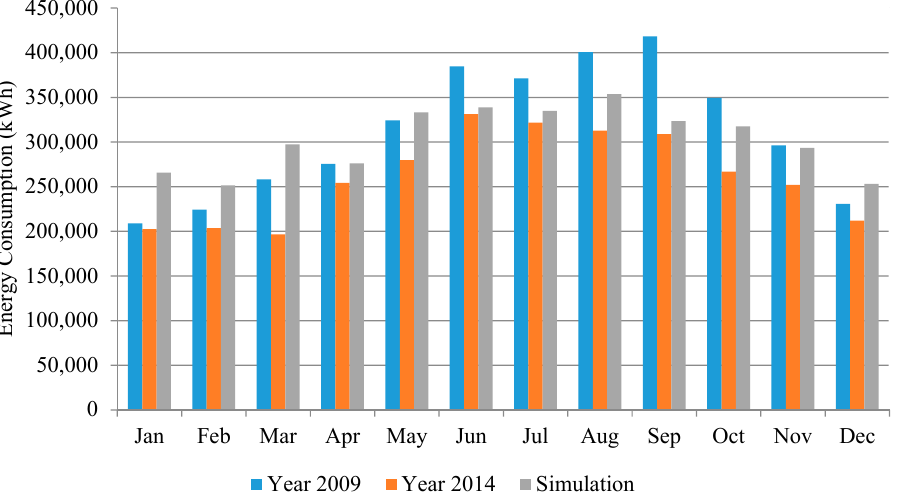
Figure 12. Monthly electricity use in the year 2009, 2014 and the simulation result.